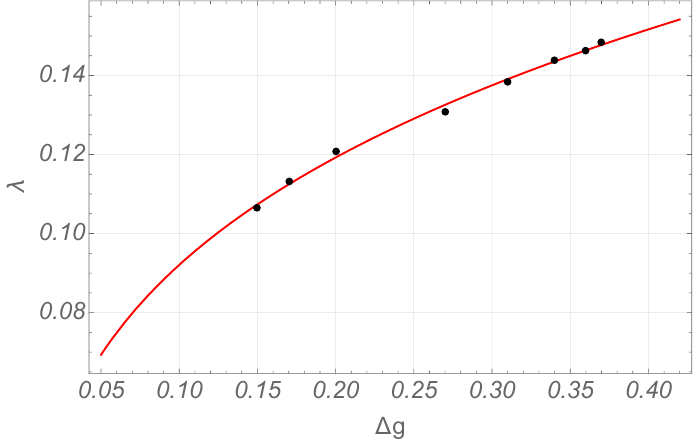
Figure 2: We fit the extracted λ values (black) to a + b ( ∆ g ) θ (red curve). When we restrict θ ∈ [ 0.1,0.4 ] the best fit is obtained for θ = 0.255. Upon including the vari- ances, the coefficients lie in the following regions: a ∈ [ − 0.04,0.01 ] , c ∈ [ 0.2,0.25 ] and θ ∈ [ 0.25,0.33 ]